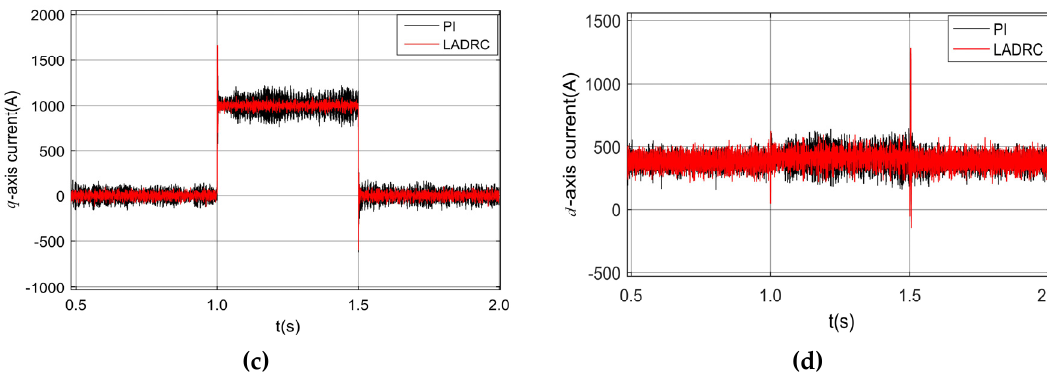
Figure 9. The change of reference current of d -axis and q -axis corresponding to the change of actual current of q -axis and d -axis under two control modes ( a ) d -axis reference current change ( b ) q -axis actual current ( c ) q -axis reference current change ( d ) d -axis actual current.